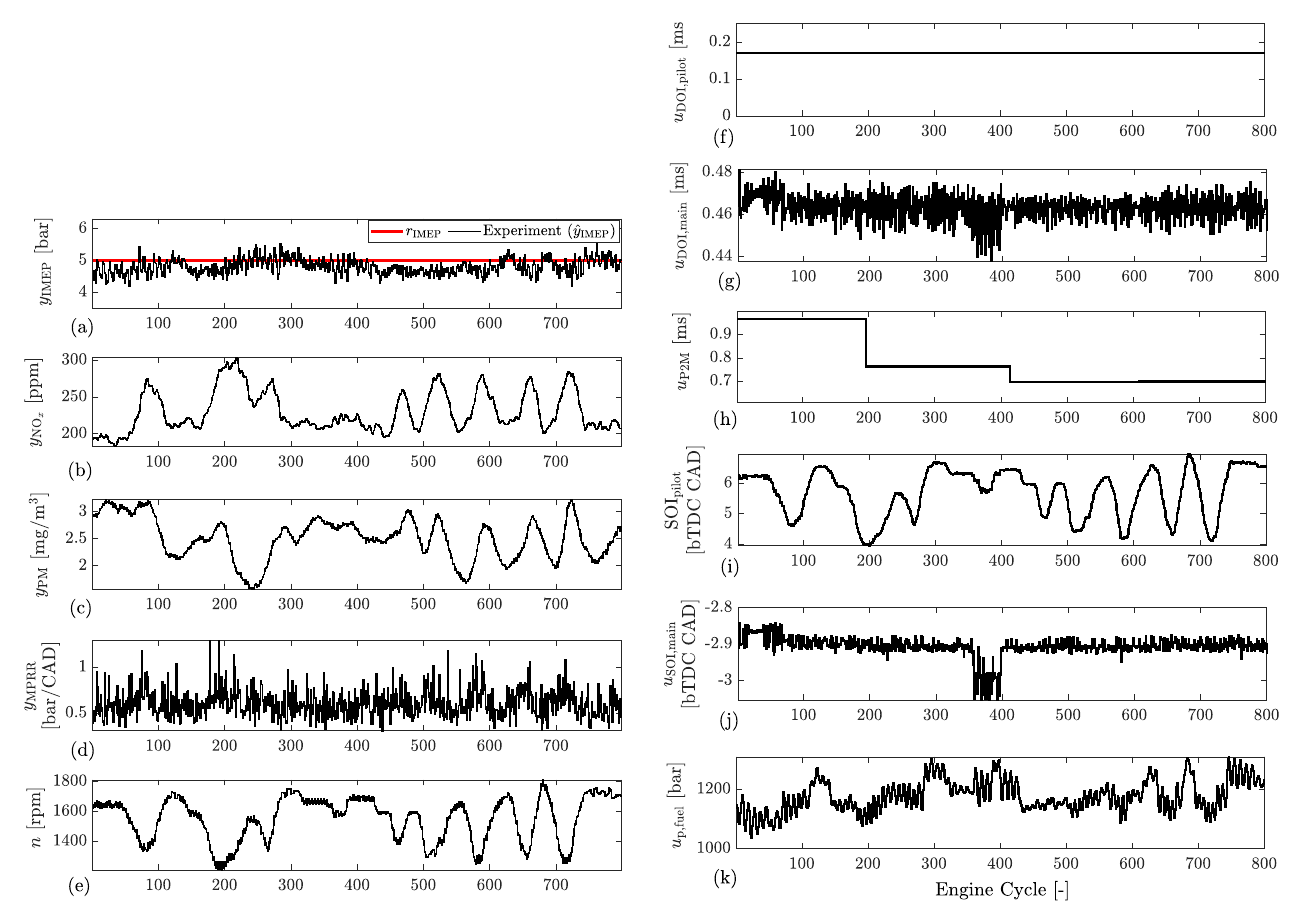
Figure 13. Experimental results: smooth speed change with a bandwidth of approximately 1 Hz—( a ) indicated mean effective pressure (IMEP), ( b ) nitrogen oxide (NO x ), ( c ) Particle Mat- ter (PM), ( d ) maximum pressure rise rate (MPRR), ( e ) engine speed, ( f ) duration of injection (DOI) of pilot injection, ( g ) DOI of main injection, ( h ) duration between end of pilot injection and start of main injection, ( i ) start of injection (SOI) of pilot injection, ( j ) SOI of main injection, ( k ) fuel rail pressure. Table 5. Proposed NMPC results compared with benchmark (BM), Cummins-calibrated ECU for dif- ferent engine operating conditions—negative value represents the LSTM-NMPC value is lower than BM. IMEP: indicated mean effective pressure, FQ: Fuel Quantity. PM: Particle